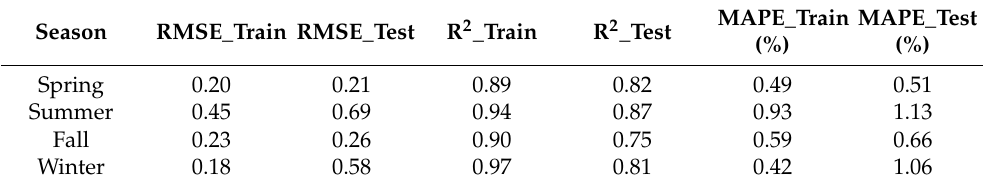
Figure 3. Relationship between the reconstructed sea surface salinity (SSS) and the underway observations OB_A for training and testing data (( a ). Spring; ( b ). Summer; ( c ). Fall; ( d ). Winter). Table 2. Evaluation metrics, root mean square error (RMSE), coefficient of determination (R 2 ), and mean absolute percentage error (MAPE) of the sea surface salinity